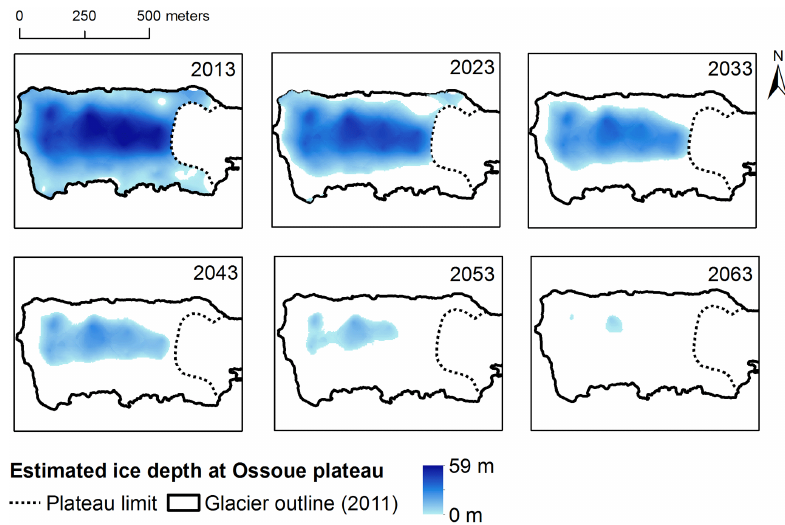
Figure 13. Map: estimated ice depth at Ossoue Plateau in the next decades. These projections are based on the sum of the ice depth estimation (measured by GPR, see Fig. 12) and the cumulative mass balance over the period of projection. The latter is based on the interpolation values of the averaged mass balance at stake locations over 2001–2013 (data per year and stakes are given in Fig. 8). Spatial resolution is 4m. East of the plateau limit (dashed line), the ice depth was unknown in